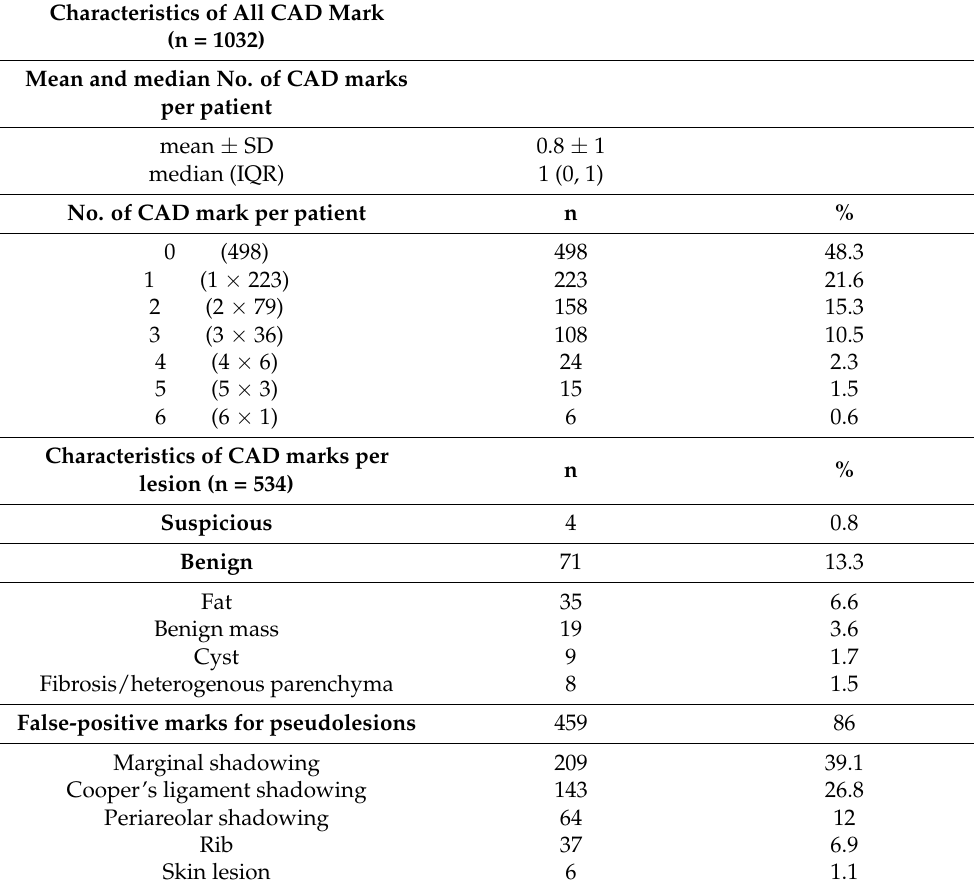
Table 3. Number and characteristics of computer-aided detection (CAD) mark.